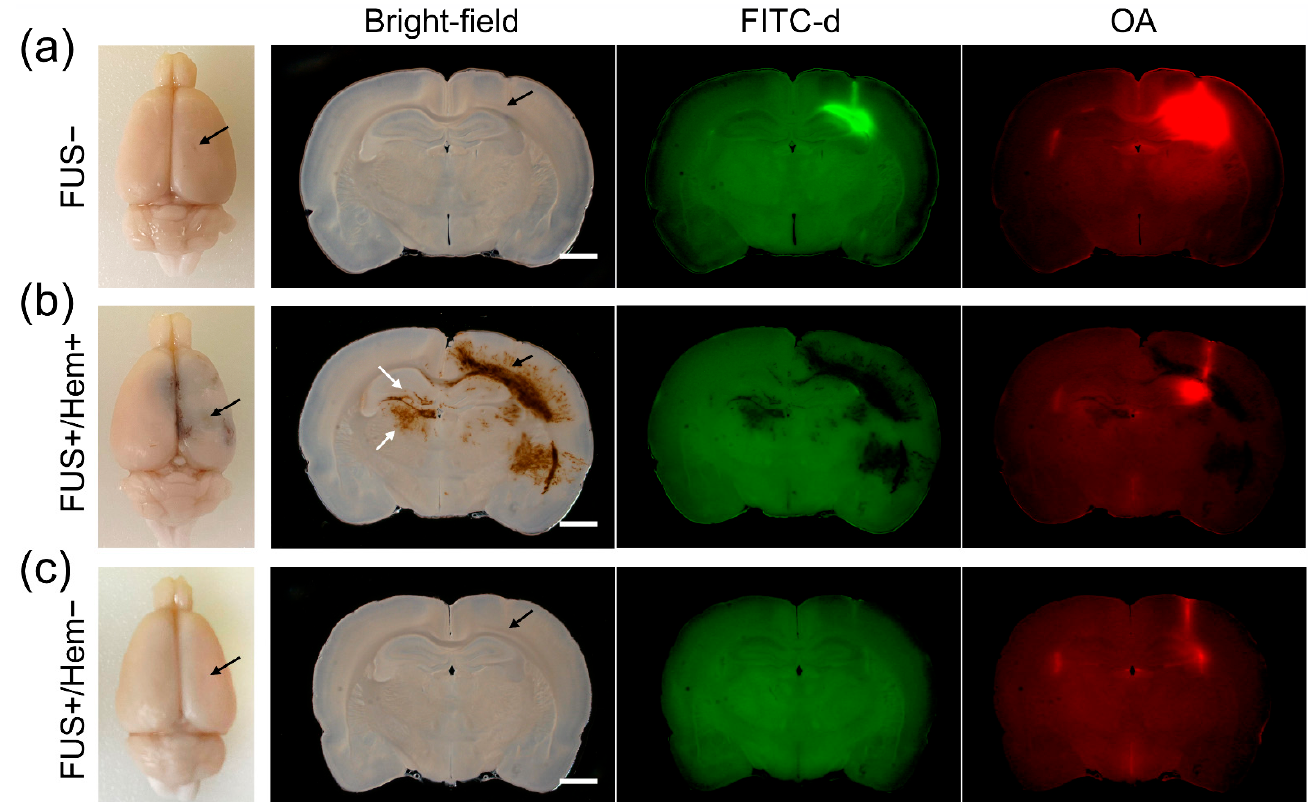
Figure 2. Brain imaging from different experimental groups. (Left to right), exemplar macroscopic images of extracted brains before sectioning, bright-field, ovalbumin (OA) and fluorescein isothiocyanate dextran (FITC-d) images from ( a ) a control, unsonicated rat (FUS − ), ( b ) a rat that received FUS showing the intracerebral hemorrhage (FUS+/Hem+), and ( c ) without any hemorrhaging (FUS+/Hem − ). Black arrows indicate the needle injection site. The white arrows specify the hemorrhage detected in the hemisphere opposite to the injection. Scale bar = 2 mm.